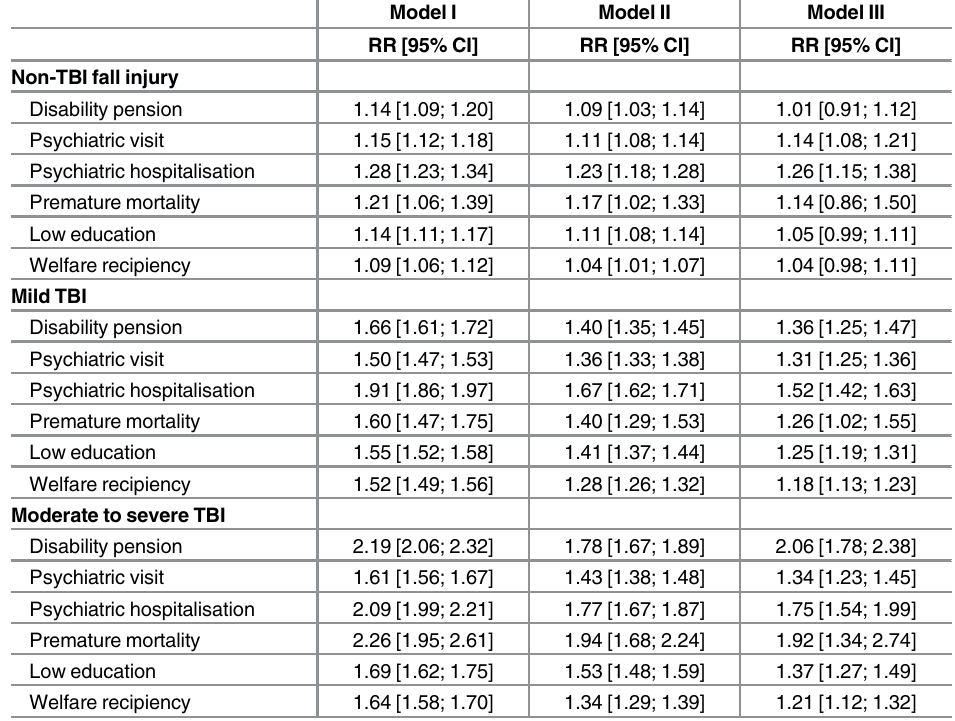
Table 5. Relative risks (RR) and corresponding 95% confidence intervals (CIs) for the associations between non-TBI fall injuries, mild TBI and moderate to severe TBI up to age 25 y on adulthood poor